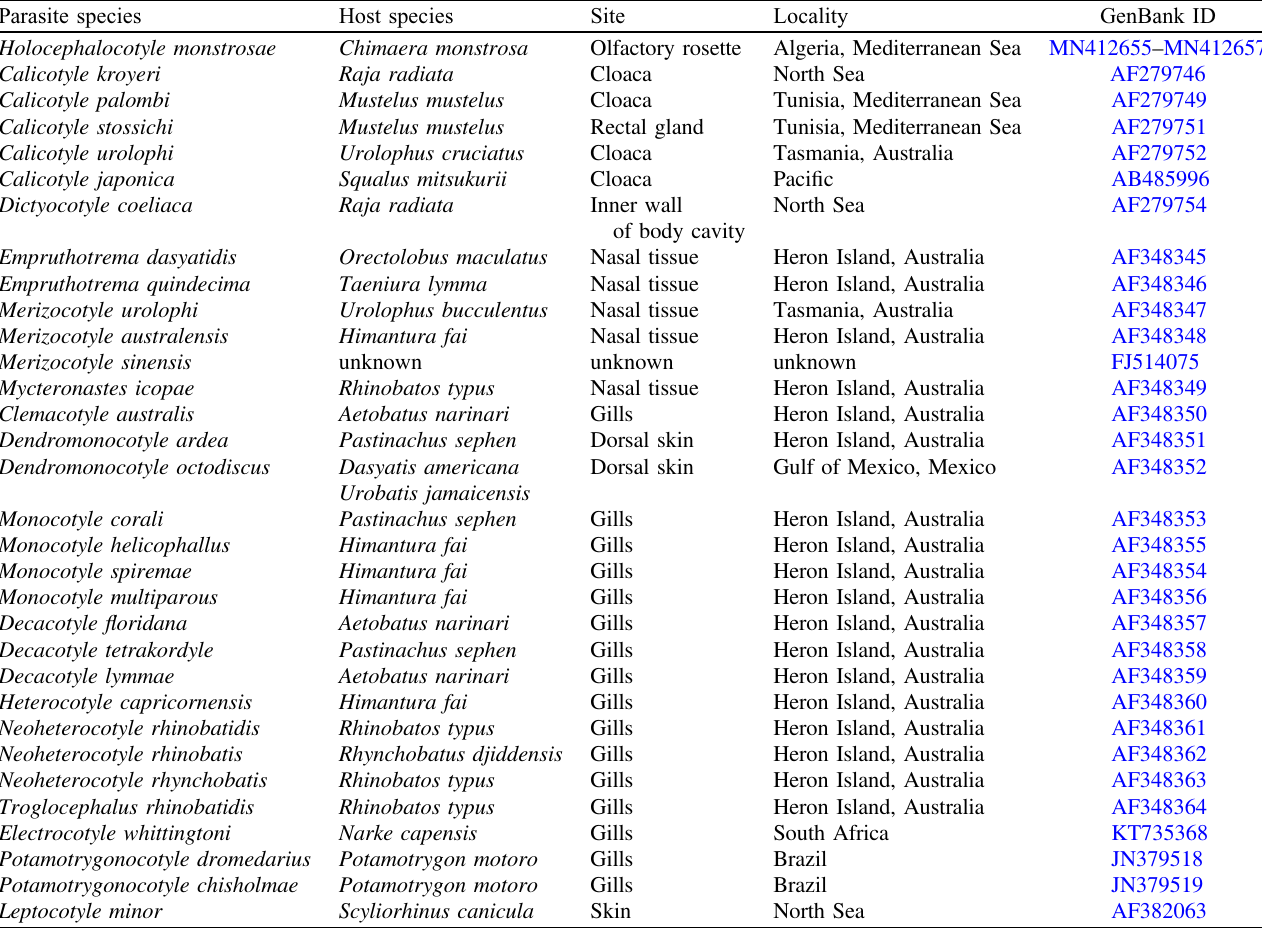
Table 1. Species of the Monocotylidae used in the molecular